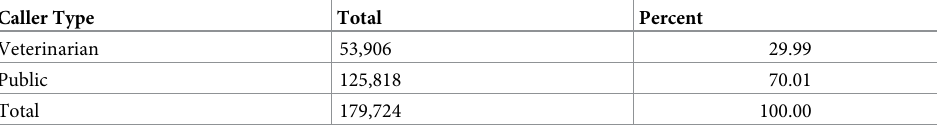
Table 1. Descriptive statistics of the calls to the APCC during the study period